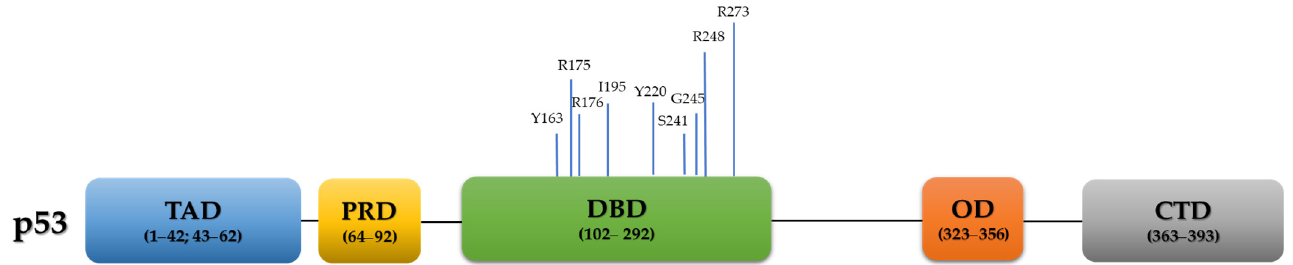
Figure 1. p53 domains and the frequency of the nine most common hotspot mutations of the human TP53 gene in HGSC, based on the TCGA data [13,23]. TAD: transactivation domain; PRD: proline-rich domain; DBD: DNA binding domain; OD: oligomerization domain; CTD: C-terminal domain.